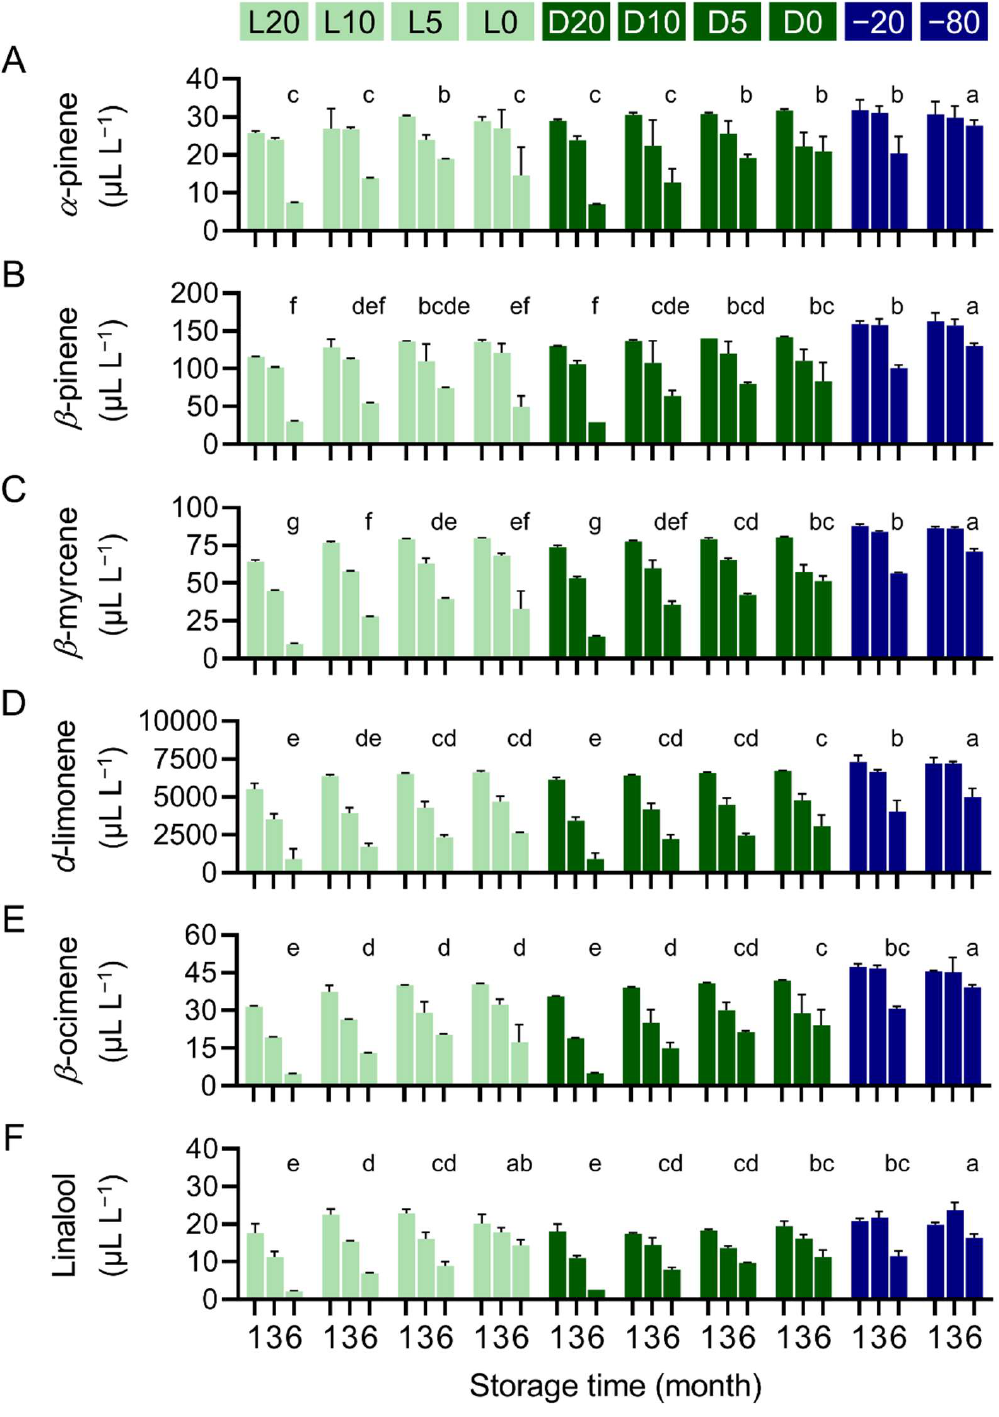
Figure 3. Change in main constituents of pomelo extract stored under different conditions. ( A ) α - pinene, ( B ) β -pinene, ( C ) β -myrcene, ( D ) d -limonene, ( E ) β -ocimene, and ( F ) linalool concentration in the PE samples stored under indicated conditions were determined by GC-MS. Data are presented as mean ± SD. The difference between values of 6 m storage was analyzed by Tukey’s tests. Significant differences ( p < 0.05, n = 3) are indicated by different alphabets.